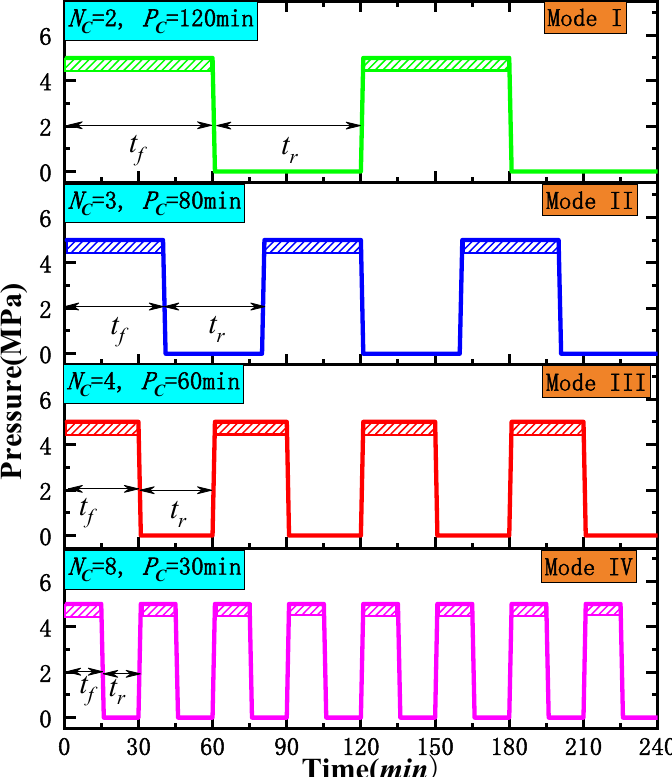
Figure 4. Modes of cryogenic L-CO 2 cyclic injection. (Note: N c represents Number of Cycle, and P c represents Period of Cycle).